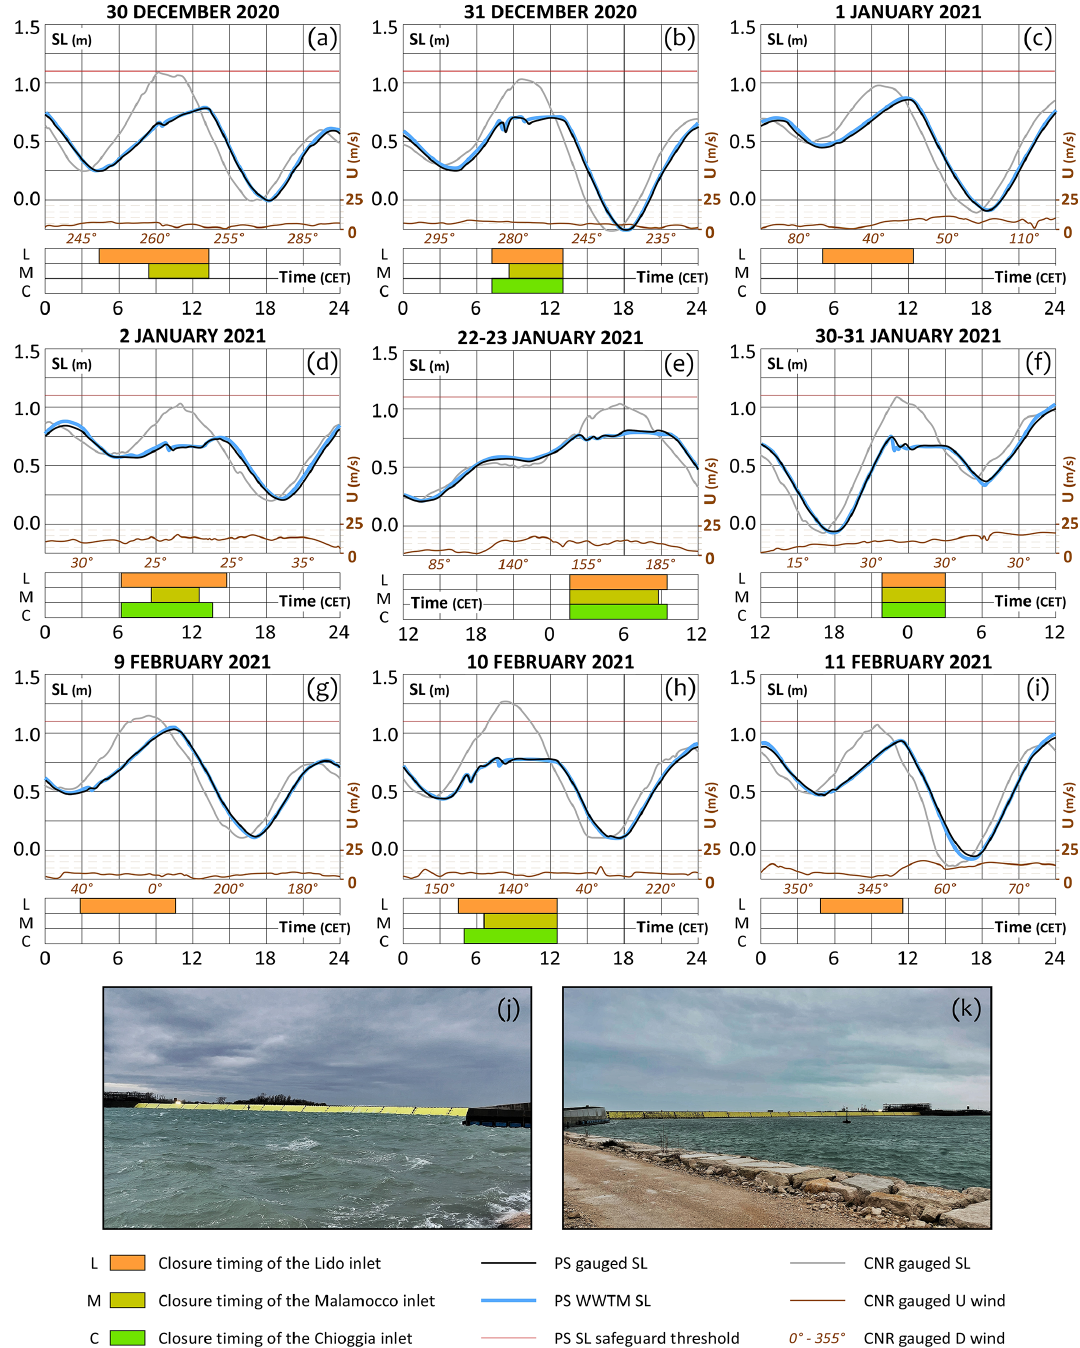
Figure A2. Events when the Mo.S.E. barriers were raised in the testing phase. (a–i) Comparison between SLs observed at the CPSM gauge of PS (black lines) and computed by the WWTM model forcing the closure of the Mo.S.E. barriers (blue lines). Grey and brown lines represent, respectively, the SLs and the wind speeds observed at the CPSM gauge of the CNR platform. The red line represents the safeguard threshold at PS (1.10m). Bars indicate the periods when the barriers of Lido (orange), Malamocco (yellow), and Chioggia (green) were temporarily closed in the respective inlets. (j) and (k) Seaward and lagoonal view of the flap gates raised in the test of 28 December 2020 (photos by R. A.